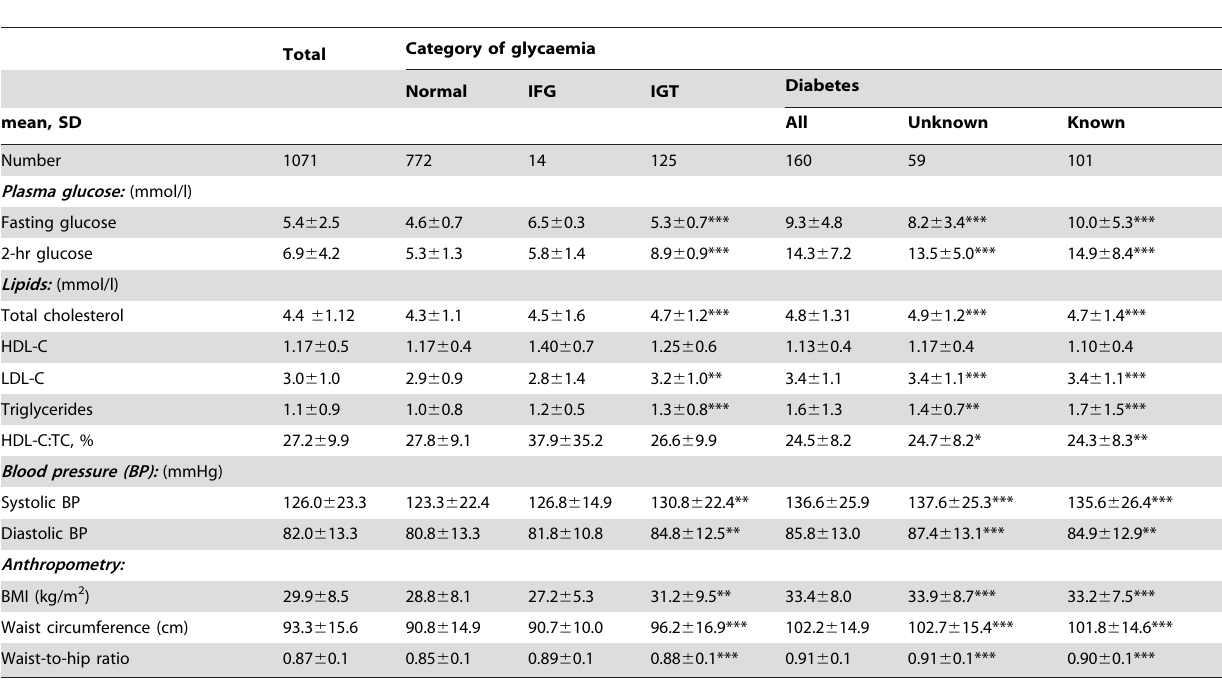
Table 2. Means and standard deviations ( 6 SD) of cardiovascular disease risk factors presented by glycaemic categories based on 1998 WHO criteria (n=1071) a